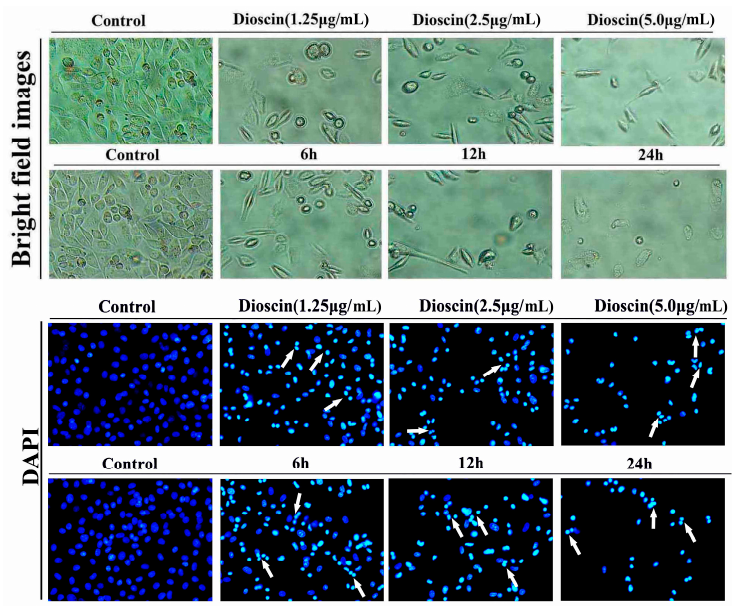
Figure 4. Morphological changes of SiHa cells treated by dioscin.